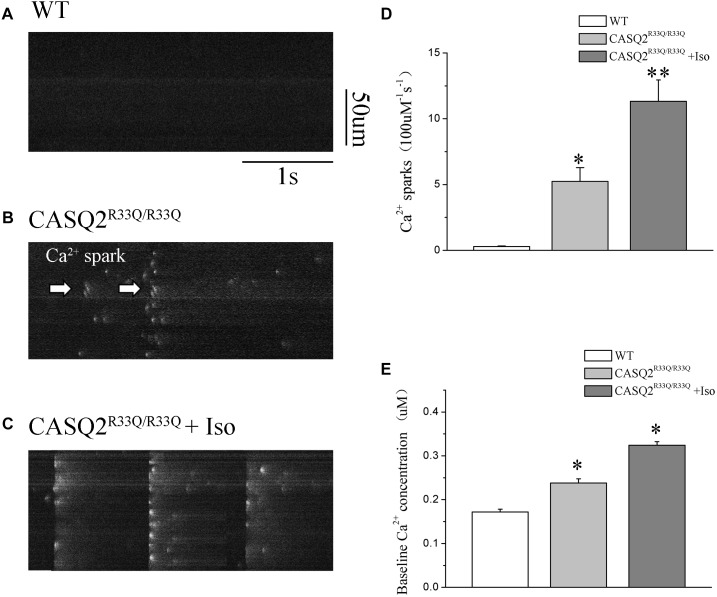
(A–C) Original recordings of Ca2+ spark in the WT and Casq2R33Q/R33Q atrial myocytes, as well as Casq2R33Q/R33Q atrial myocytes with 1 μM isoproterenol. (D) Spontaneous Ca2+ spark reflected by the incidence of Ca2+ spark frequency (100 μm-1.s-1). (E) Comparison baseline Ca2+ concentration among groups. ∗P < 0.05 vs. WT, ∗∗P < 0.01 vs. WT.